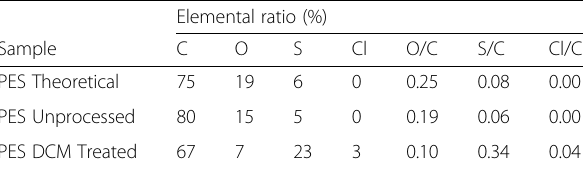
Table 2 Summary of elemental modifications on PES membranes after DCM plasma treatment ( n =